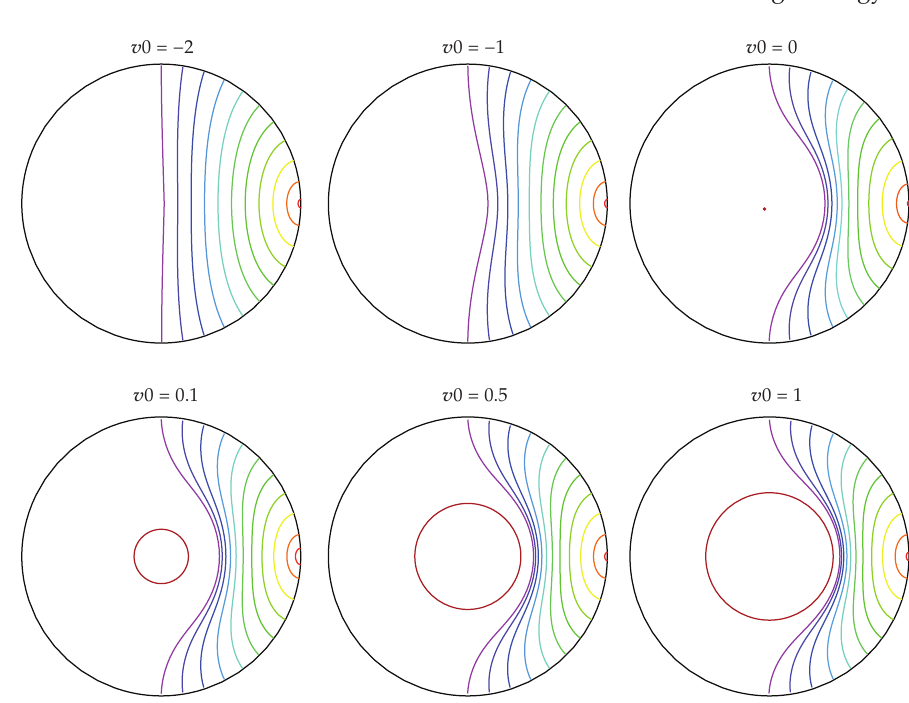
Figure 11: Spatial projection of extremal surfaces in Vaidya-AdS (cid:3) collapsing black hole (cid:4) geometry, calculated at various times in the black hole formation process. The outer (cid:3) black (cid:4) circles correspond to the AdS boundary at time given by the v 0 indicated; the inner (cid:3) red (cid:4) circles correspond to the event horizon cross-section at corresponding time. The remaining curves correspond to the extremal surfaces anchored on the boundary, colour-coded by the size of the boundary region they encompass. At early times v 0 before the black hole forms, these extremal surfaces coincide with minimal surfaces in pure AdS. We can see that as the black hole grows, these surfaces are “repelled” to remain outside the